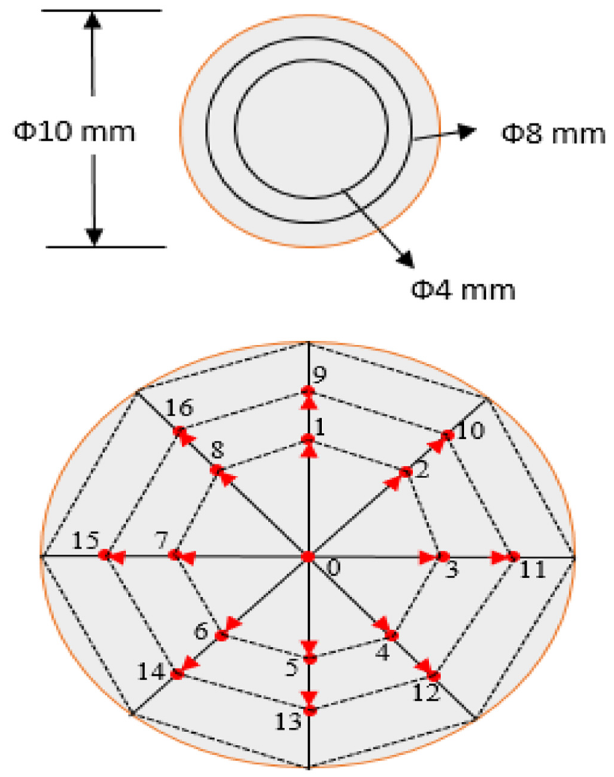
Fig. 10. Spider web diagram showing the nodal spots for hardness measurement.